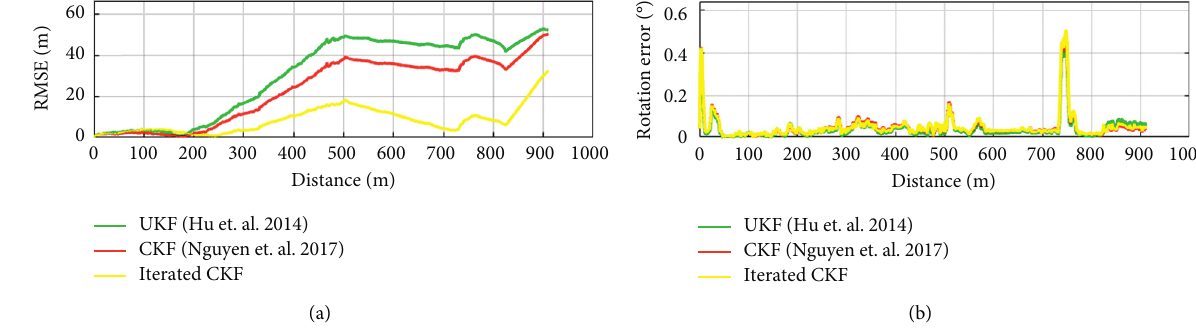
Figure 9: RMSE (a) and rotation error (b) in the experiment with dataset 2011_09_30_0034.